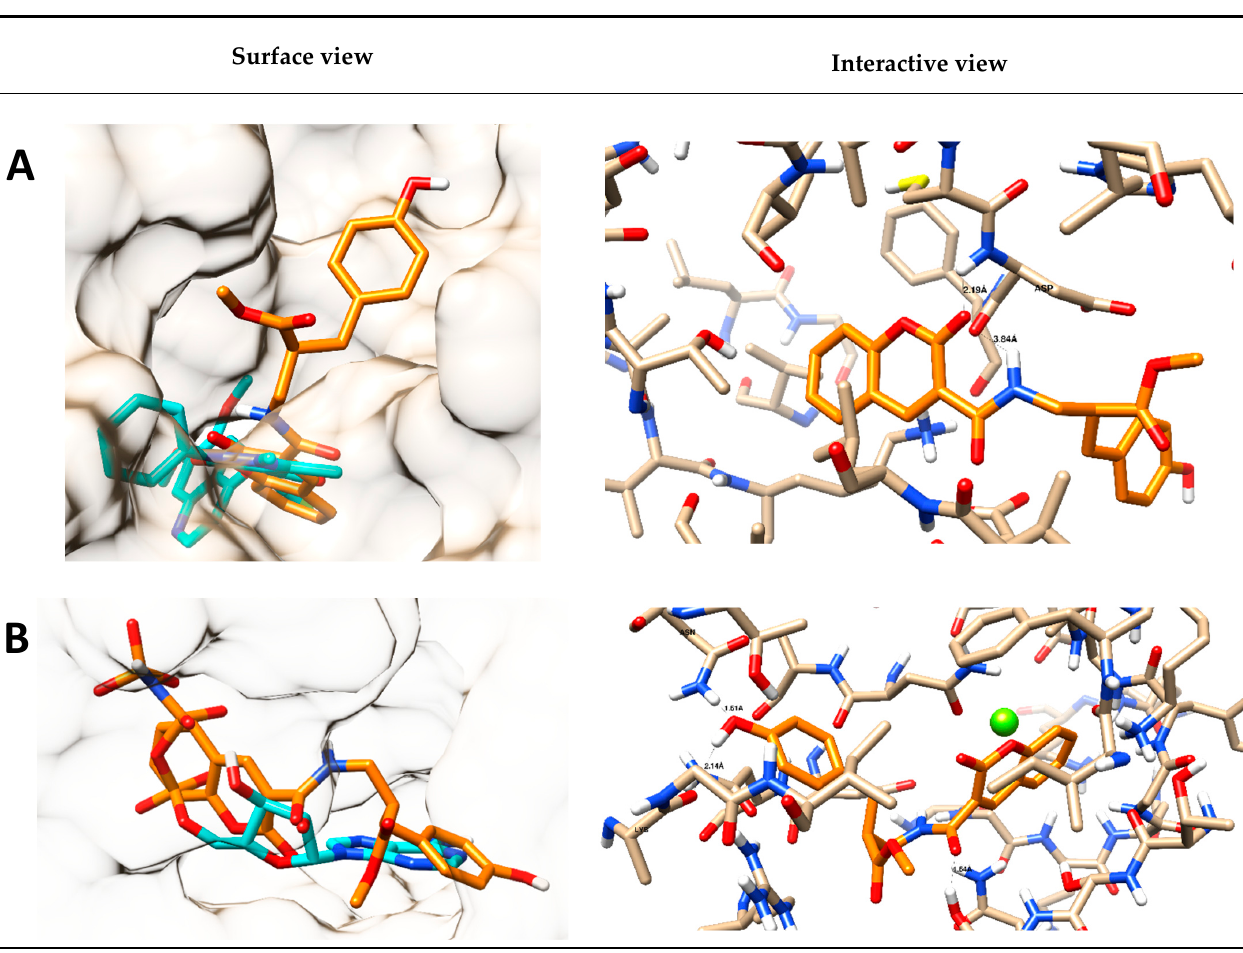
Figure 3. Binding disposition of the co-crystallized ligand (cyan-colored) and the docked compound 4k (orange-colored) towards ( A ): VEGFR2 (PDB = 3U6J); ( B ): Topoisomerase II (PDB = 1ZXM). Left panel is the surface representation, while right panel is the interactive binding mode with the key amino acids. The 3D representation was generated by Chimera-UCSF.